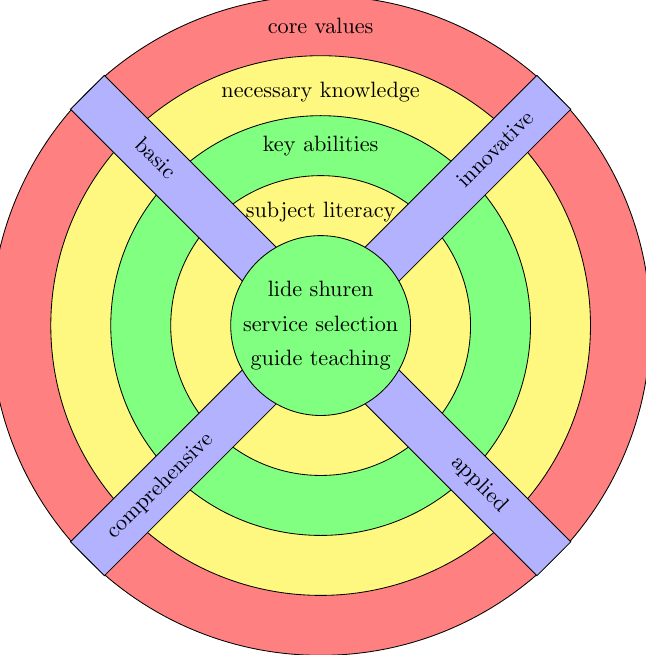
Figure 1. The general model “one core, four layers and four wings” in the latest China national college entrance examination evaluation system. (Lide shuren means moral